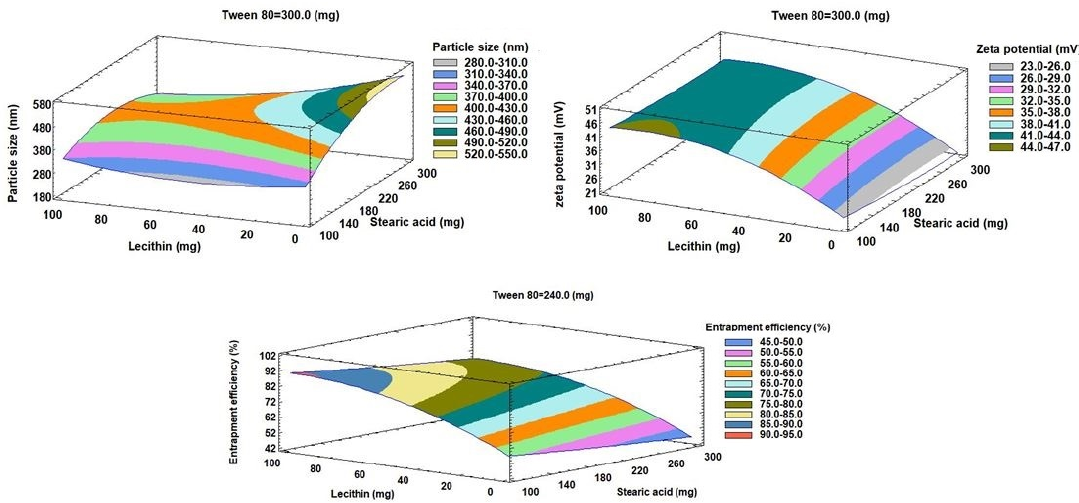
Figure 3. Estimated response surface plots for the effects of the investigated factors on all responses (Y 1 –Y 3